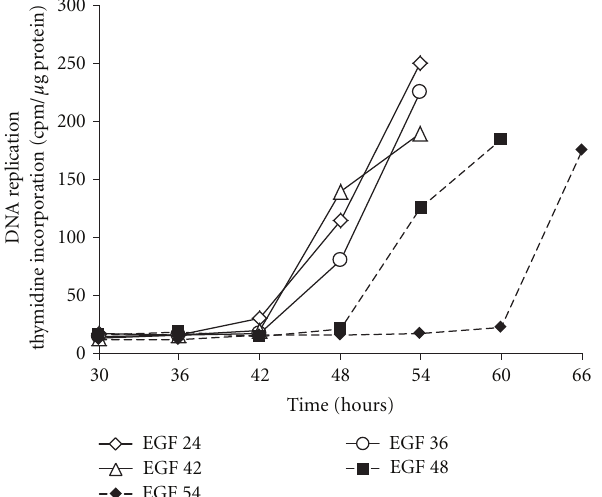
Figure 5: Evidencing the R point in primary rat hepatocytes. In absence of EGF rat hepatocytes do not replicate DNA. However, they sequentially express early G1 phase markers strongly suggesting a cell cycle arrest in midlate G1 phase. The mitogen-dependent restriction point was localized by performing stimulation with EGF at di ff erent time points (24, 36, 42, 48, 54h) after seeding the hep- atocytes. Then the DNA replication was monitored by measuring the incorporation of radiolabelled thymidine into the hepatocyte DNA. For stimulations between 24 and 42h, DNA replication began between 48 and 54h. When cells were stimulated at 48 or 54h, DNA replication was significantly delayed demonstrating that the progression in G1 phase regardless of stimulation by EGF ended around 42 h and that the progression beyond this point required a mitogenic